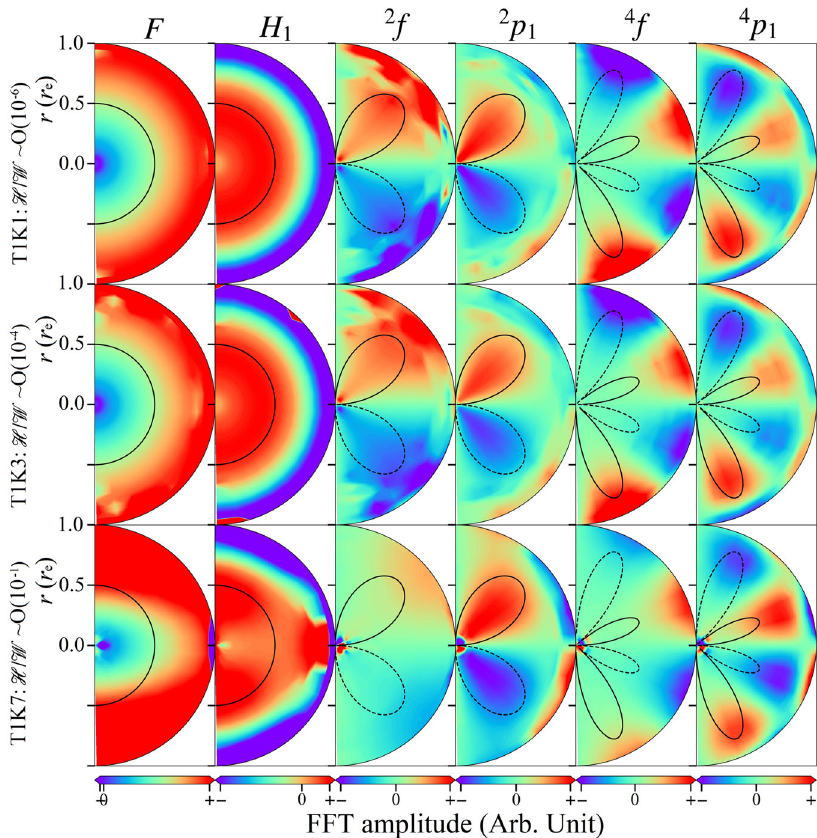
Fig. 1 Visualizations of eigenfunctions of the six dominant oscillation modes using the data of three equilibrium models (T1K1, T1K3 and T1K7). The fundamental quasi-radial ( l = 0) mode F and its fi rst overtone H 1 are predominantly excited under l = 0 perturbation; the fundamental quadrupole ( l = 2) mode 2 f and its fi rst overtone 2 p 1 are predominantly excited under l = 2 perturbation; the fundamental hexadecapole ( l = 4) mode 4 f and its fi rst overtone l = 4 perturbation. Each polar colour plot shows the spatial map of FFT amplitude at the eigenfrequency of the mode, 4 p 1 are predominantly excited under where the radial axis is normalized to the equatorial radius r e of each model. On top of each colour plot, there is a polar line plot visualizing the θ -part of the spherical harmonic in the corresponding perturbation function, where the distance from the origin to the line measures the magnitude of the spherical harmonic in that θ -direction, while the solid and dotted portions represent the positive and negative parts of the spherical harmonic, respectively. Each line plot is scaled arbitrarily for clearer illustration. It can be seen that the eigenfunctions of the higher-order quadrupole ( l = 2) and hexadecapole ( l = 4) modes have more nodes in the θ -direction compared to the quasi-radial ( l = 0) modes, while the eigenfunction of each fi rst overtone has more nodes in the r -direction compared to its fundamental mode. Furthermore, each eigenfunction qualitatively agrees with the spherical harmonic in the corresponding perturbation